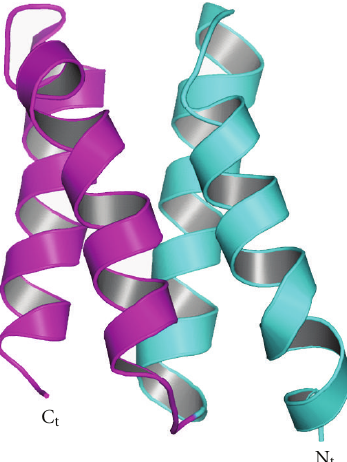
Figure 5: An example of HEAT-repeat motifs. Two consecutive α - helical hairpins are